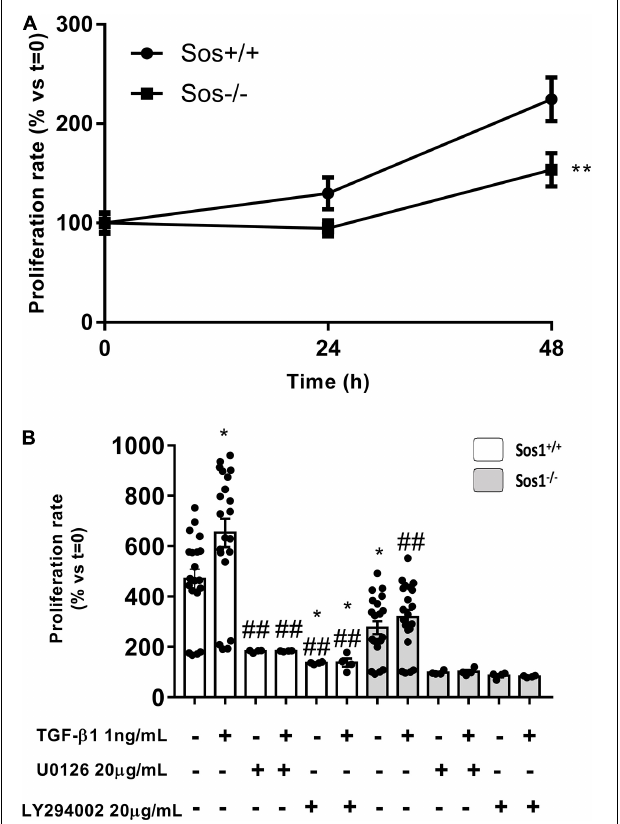
FIGURE 3 | Effect of Sos-1 deficiency and effect of MEK/ERK or PI3K/AKT inhibition on fibroblast proliferation. Cell proliferation measured at 48 h by crystal violet assay (A) , expressed as% vs. t = 0 (100%); effect of phospho-Erk inhibition with 20 µ g/mL U0126 or phospho-Akt inhibition with 20 µ g/mL LY294002 on cell proliferation induced by TGF- β 1 treatment (1 ng/mL, 48 h), evaluated by crystal violet assay (N = 4-20, in three independent experiments) (B) ; histogram in B represent the mean ± S.E.M., expressed as percentage over t = 0 h (Sos1 + / + fibroblasts in basal conditions, 100%). Statistically significant differences: ** p < 0,01 vs. Sos1 + / + fibroblasts in basal conditions; ## p < 0,01 vs. Sos1 + / + fibroblasts treated with 1 ng/mL TGF- β